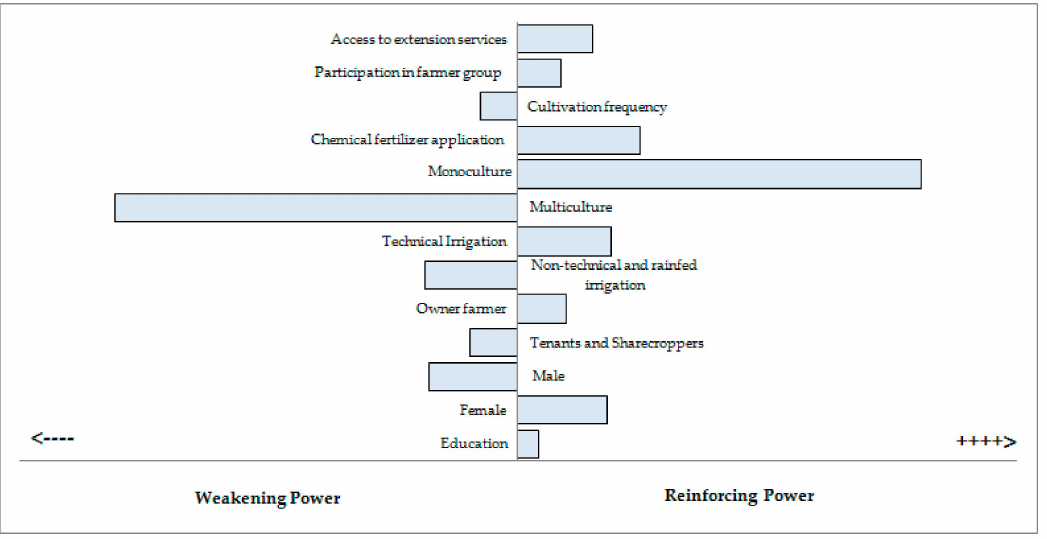
Figure 3. The reinforcing and weakening factors of the climate change perceived